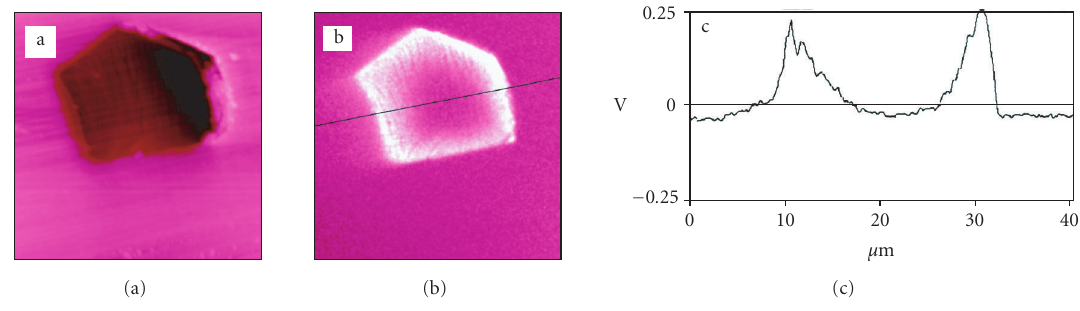
Figure 45: Simultaneous shear-force AFM (a) (40 μ m, Z range 2 μ m) and fluorescence SNOM (b) of a microtome cut surface of a dyed polyester fiber (dye 14 ) embedded in Technovit 7100, showing ring dyeing in the optical contrast and the cross section (c) through the fluorescence intensity profile as indicated in (b).